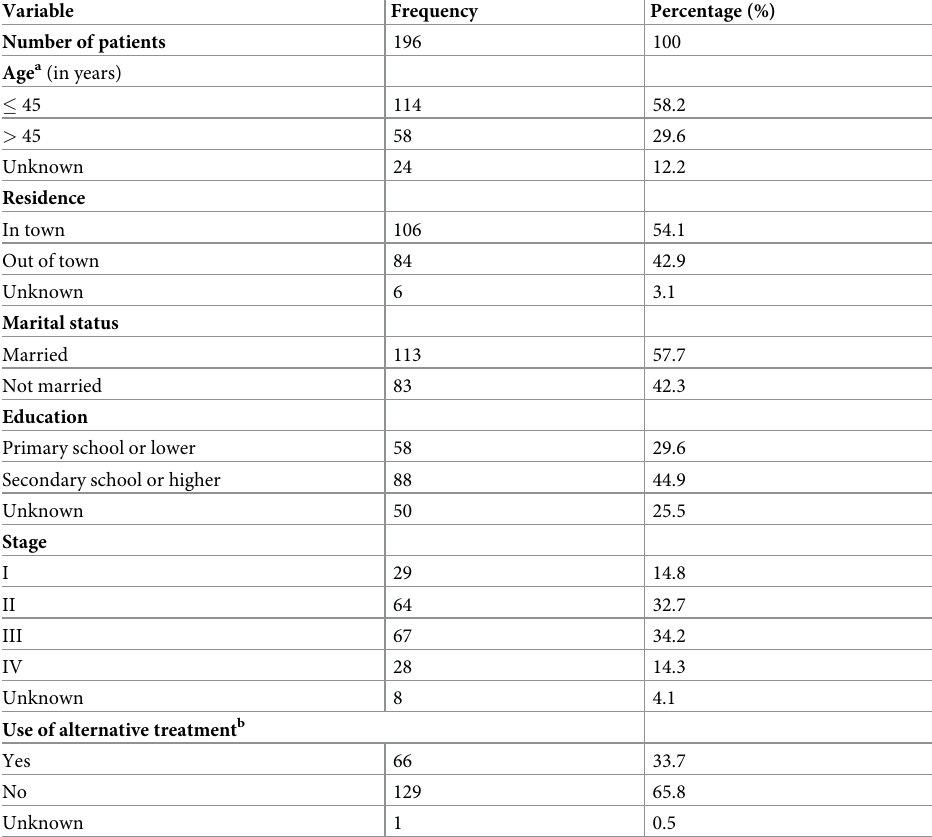
Table 1. Socio-demographic and clinical characteristics of study